Question: What form of chart is displayed?
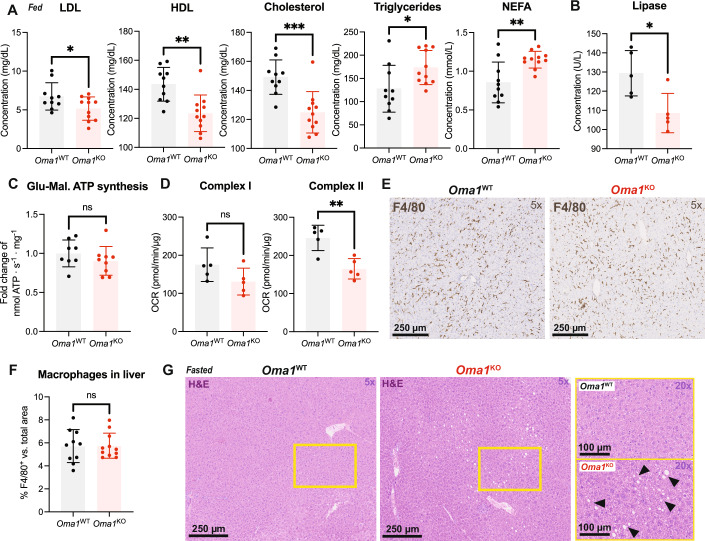
Answer: bar